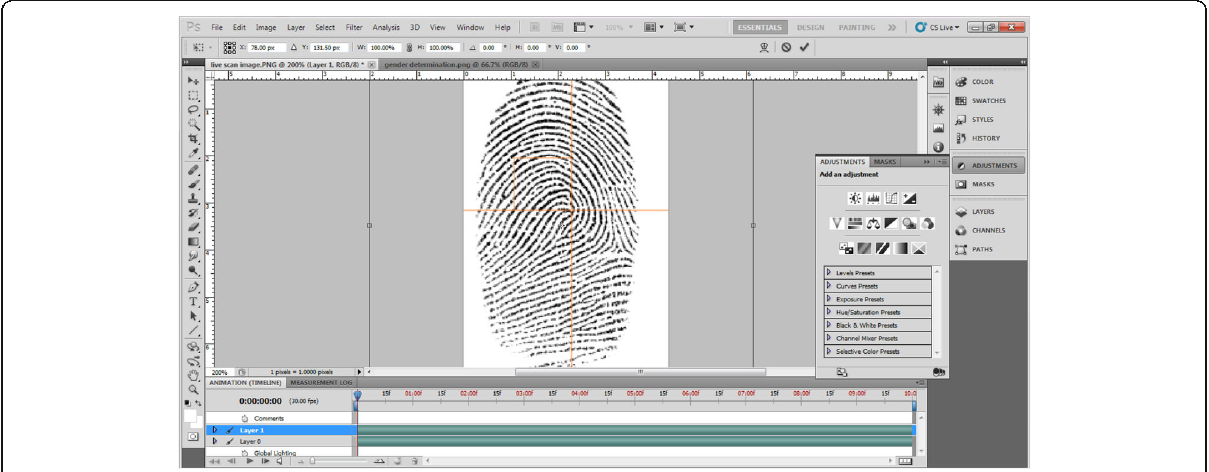
Fig. 2 Showing superimposition of scale according to method suggested by Thakar and Sharma (2016) with the help of Adobe Photoshop cs5 software. Magic wand tool was used to select the scale so that it can be superimposed on the scanned image of selected fingerprint